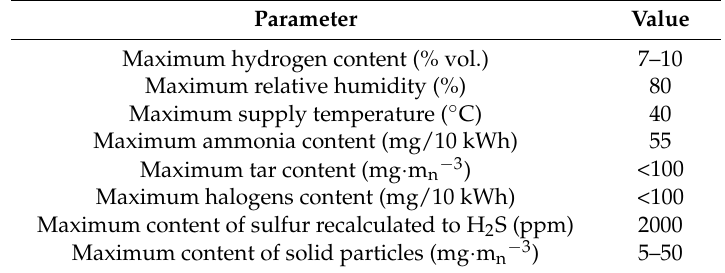
Table 2. Requirements for gas quality for compression ignition and spark ignition engines [17].